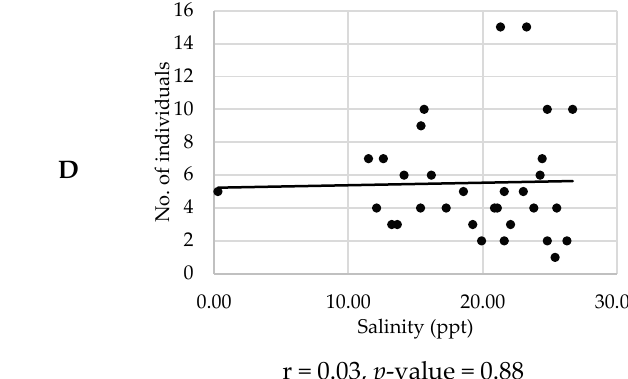
r = 0.03, p -value = 0.88 Figure 9. The number of individuals in a group of Irrawaddy dolphins displaying socializing behaviour versus abiotic factors (depth ( A ), turbidity ( B ), SST ( C ) and salinity ( D )). (Travelling) Pearson’s Correlation Coefficient at p <0.05